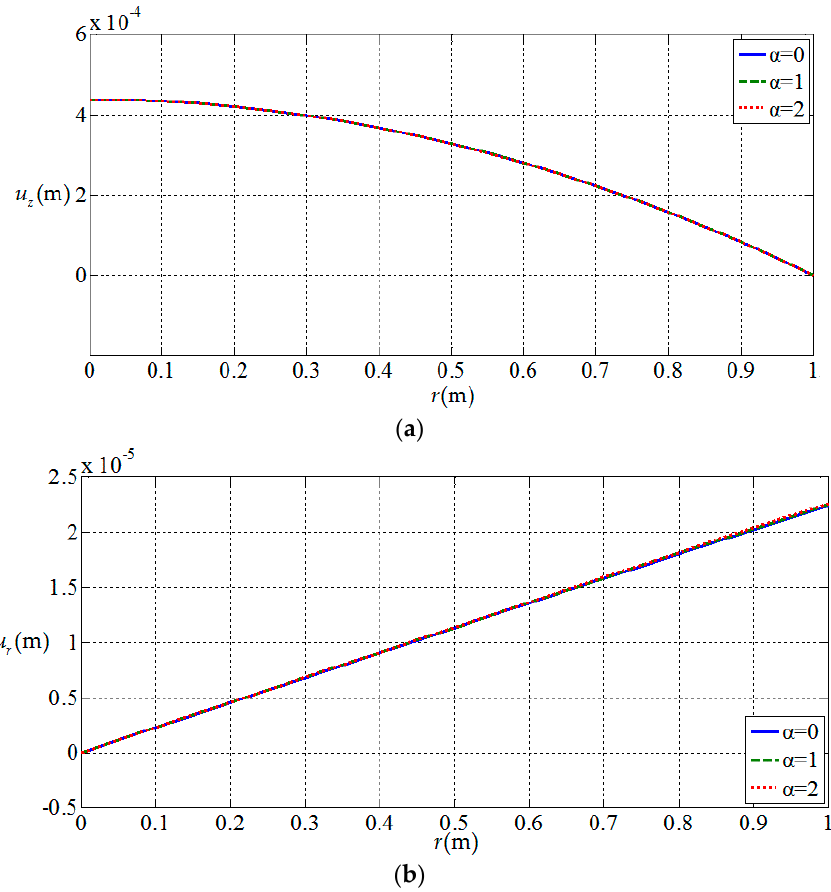
Figure 10. Variation of elastic displacement with coordinates r at z = h /4. ( a ) z -direction displacement u z ( r , h /4 ) at z = h /4; ( b ) radial displacement u r ( r , h /4 ) at z = h /4.